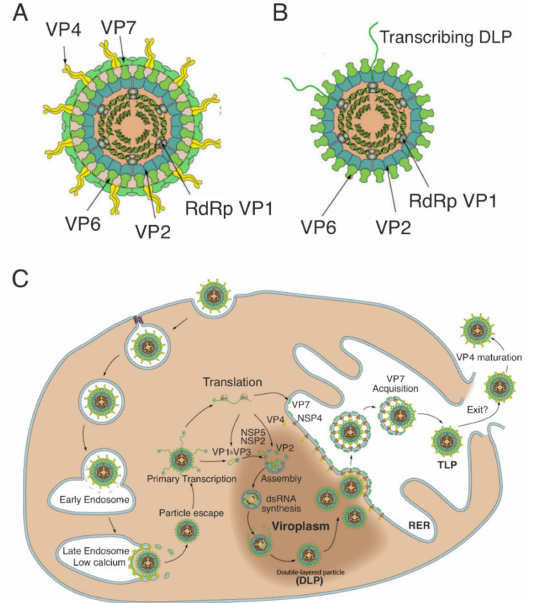
Figure 1. Rotavirus structure, replication cycle. ( A , B ) Schematic representation of triple-layered and double-layered rotavirus particles (TLPs and DLPs, respectively). Outer layer: VP7, VP4 (spikes); middle layer: VP6; inner layer (core): VP2. The core contains 11 segments of dsRNA (diagram- matically shown as concentric rings) and the viral transcription–replication complex, consisting of the RNA-dependent RNA polymerase (RdRp), VP1, and the capping enzyme, VP3. Rotavirus DLPs are transcription active, producing (+)ssRNAs from each genomic RNA segment. Adapted from: ViralZone, SIB Swiss Institute of Bioinformatics; ( C ) Rotavirus replication cycle (diagram) including formation of viroplasms. For details, see text. Adapted from: ViralZone, SIB Swiss Institute of